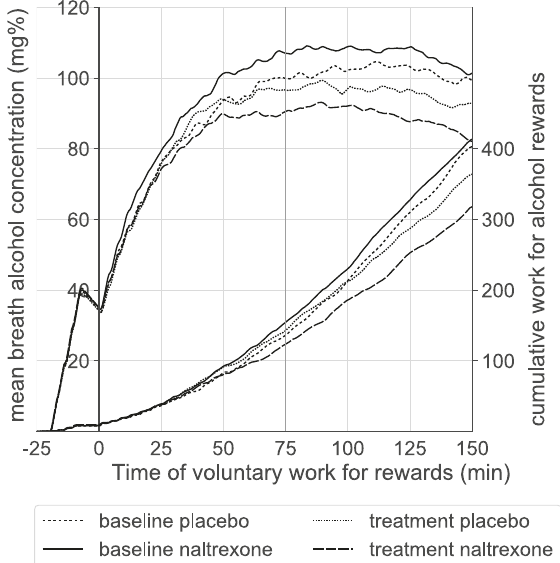
Fig. 3 Mean BrAC and cWFA over experimental time. Time − 25 until 0 min = priming interval with experimenter-prompted work.